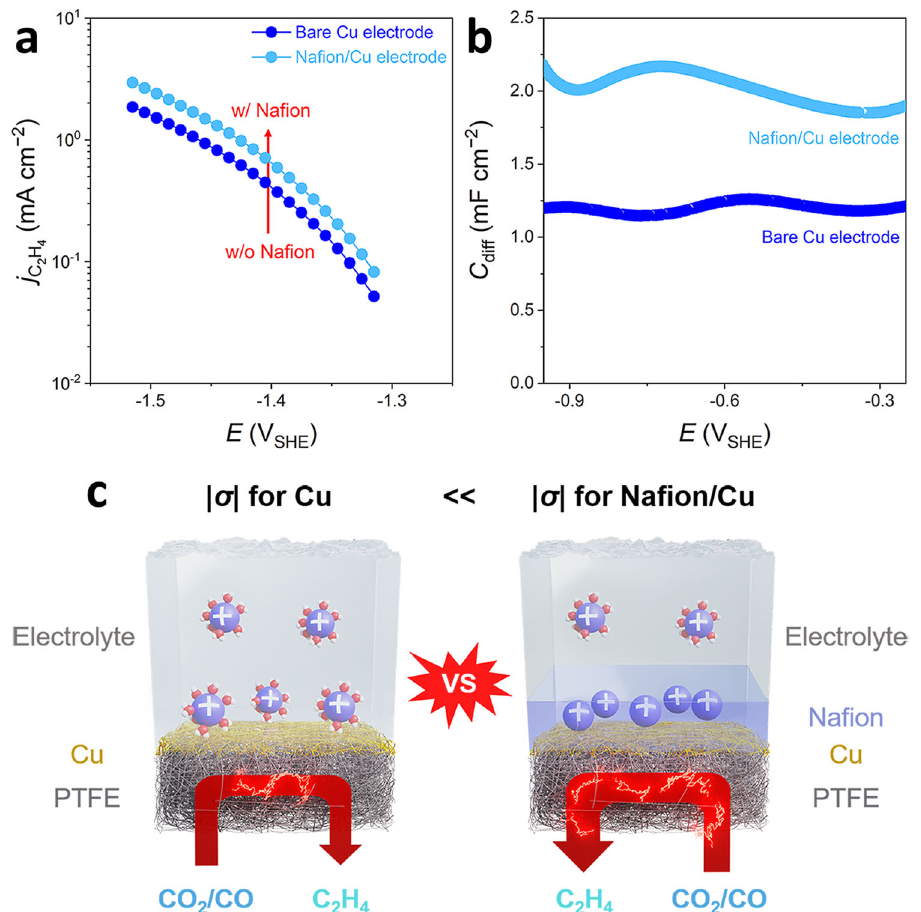
Fig. 5 | Boosted C 2 H 4 formation on the Na fi on-coated Cu electrode. a The j C2H4 vs . potential curvesand b the C diff curves, measured on bare and Na fi on-coated Cu electrodes in 5M KOH electrolyte. c Schematic descriptions of the